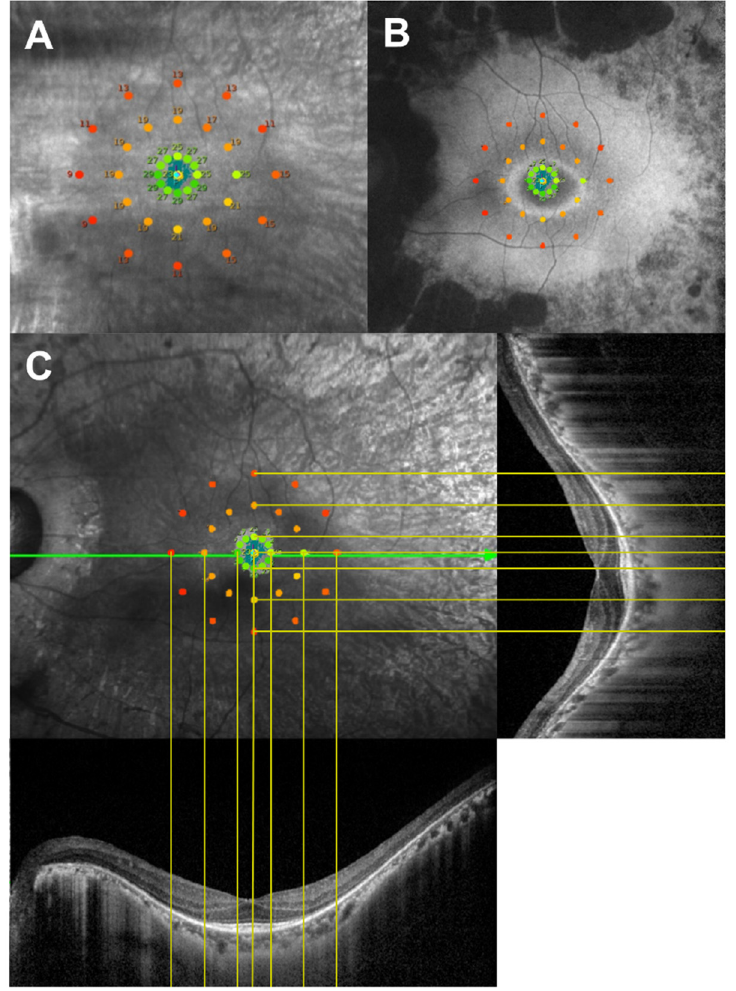
Figure 1. ( A ) Schematic illustration of a microperimetry sensitivity map comprising 37 testing points. ( B ) Representative superimposed image of microperimetry sensitivity map on the fundus autofluorescence image. ( C ) Optical coherence tomography images measure retinal thicknesses at the corresponding region to a stimulation point according to the superimposed translucent fundus microperimetry